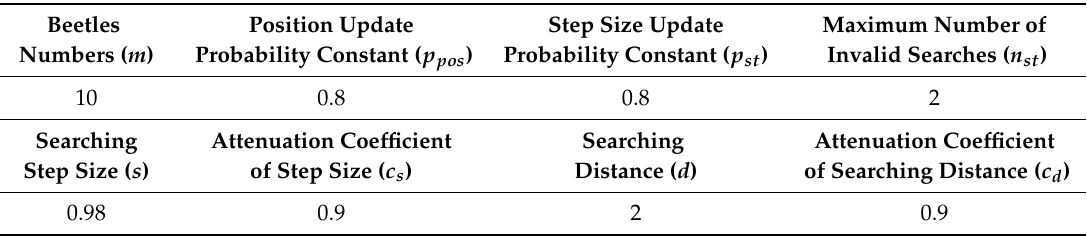
Table 2. Parameters setting of BSAS